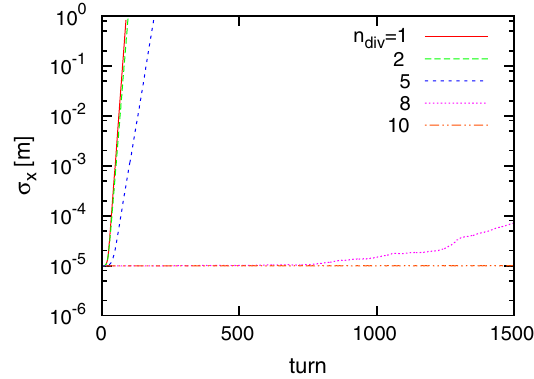
FIG. 8. Evolution of beam size for single beam tracking in FCCee-Z. The bunch population ( ξ ) and synchrotron tune are x ¼ 1 , 2, 5, 8, 10 in a divided into n div